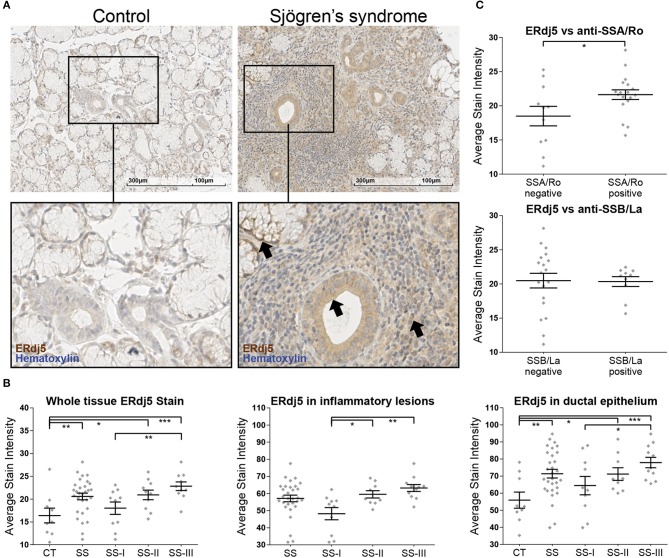
Immunohistochemical detection of ERdj5 in human MSG tissues and morphometric analysis. (A) Representative images of ERdj5 staining in CT and SS subjects. Objective magnification: 20x. Positive signal: brown; counterstain: hematoxylin/blue. Arrows: Positive signal for ERdj5 in the acinar cells (left), in the ductal epithelium (middle), and within the inflammatory region (right). (B) Morphometric analysis of in situ ERdj5. Patients are classified into three SS subgroups by the grade of the inflammatory lesions. Left panel: Stain intensity of positive signal within the entire tissue. Middle panel: Stain intensity of positive signal within the inflammatory lesions. The CT group had no inflammatory lesions to be measured and is omitted from the chart. Right panel: Stain intensity of positive signal within the ductal epithelium. (C) Correlation between whole tissue ERdj5 stain intensity and presence of autoantibodies. Upper panel: patients were classified according to serum reactivity to Ro/SSA. Lower panel: patients were classified according to serum reactivity to La/SSB. In all charts, data are represented as individual points for each subject, overlaid by a horizontal mean value ± SEM. Group “SS” encompasses all patients, and was not included in the ANOVA analysis, only in t-test vs. CT. Statistically significant differences indicated as * for p < 0.05, ** for p < 0.01, and *** for p < 0.001.